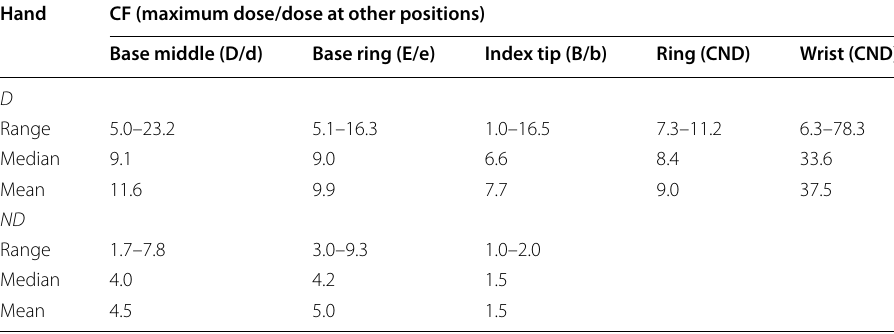
Table 4 Range, median and mean values of the CFs calculated for both hands Hand CF (maximum dose/dose at other